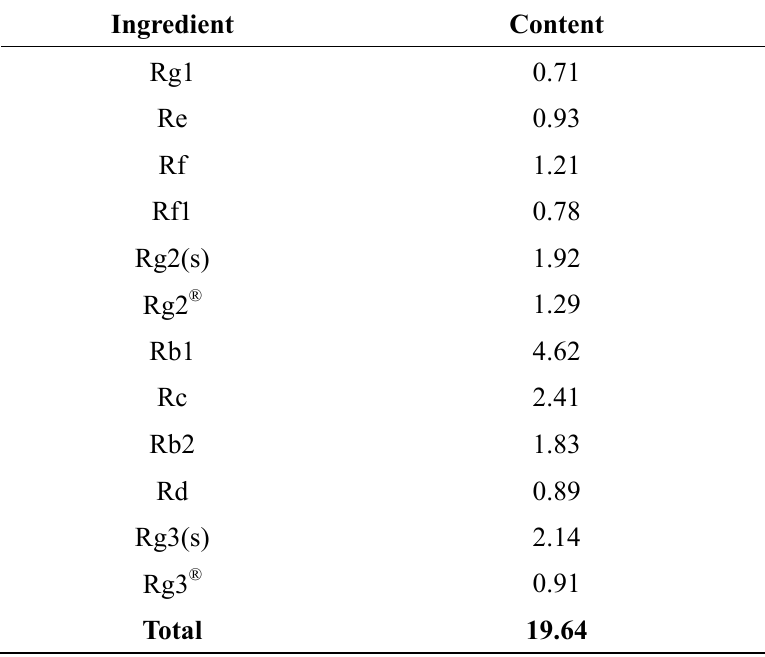
Table 1. Ginsenosides composition in Red-Ginseng Extract